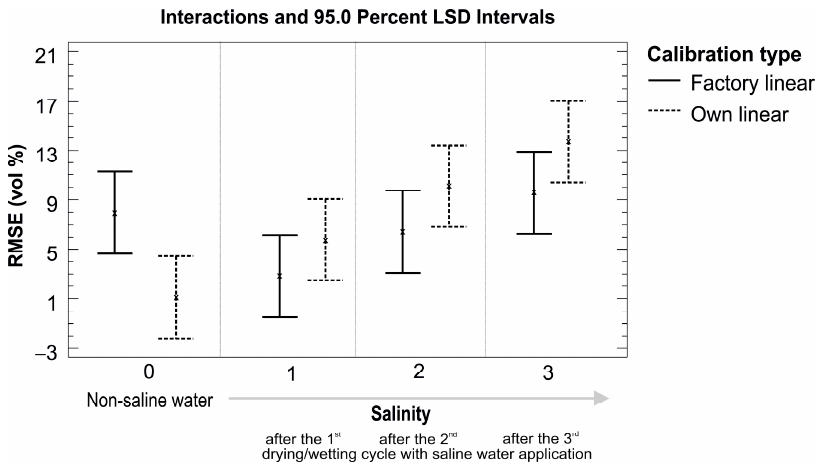
Figure 12. Factory and our own calibration comparison based on RMSE (vol %) values for saline conditions.